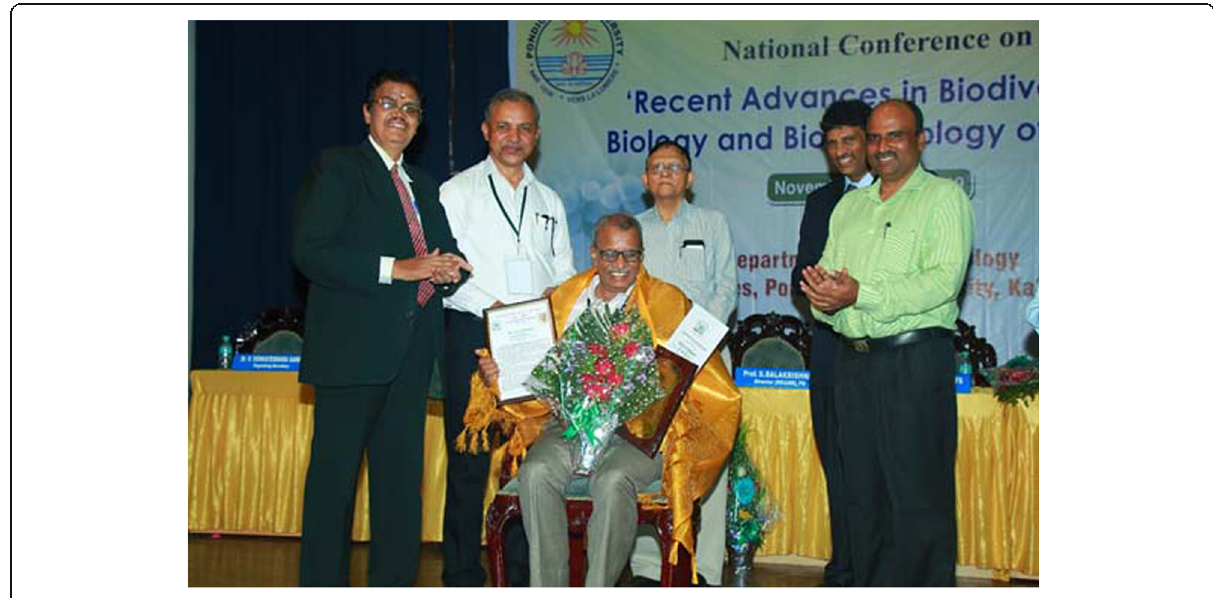
Fig. 17 Life-time Achievement Award presented to K.R. Sridhar ( seated ) by the Chief Guest Shri Justin Mohan ( right